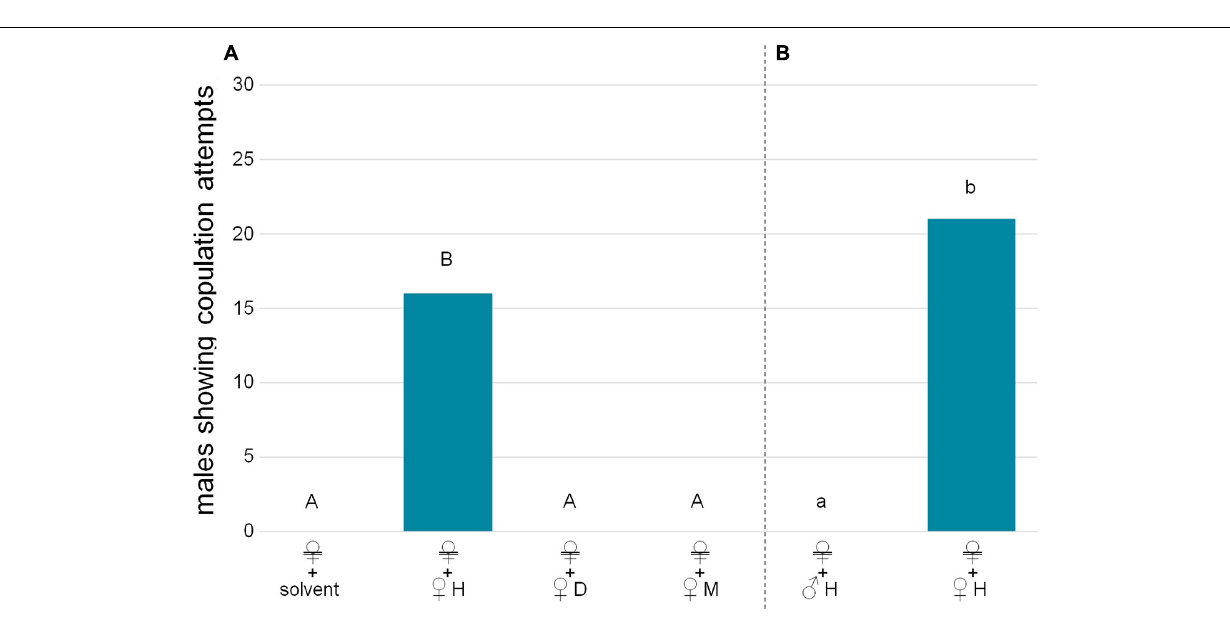
Frontiers in Ecology and Evolution |